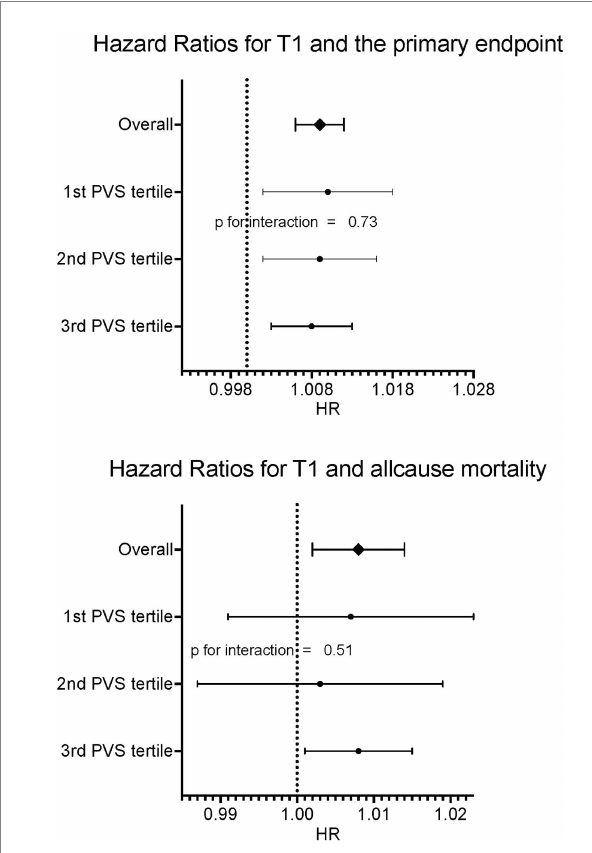
FIGURE 3 Forrest plots for primary and secondary endpoints according to PVS tertiles. No relevant interaction between PVS tertiles and native T1 could be found.